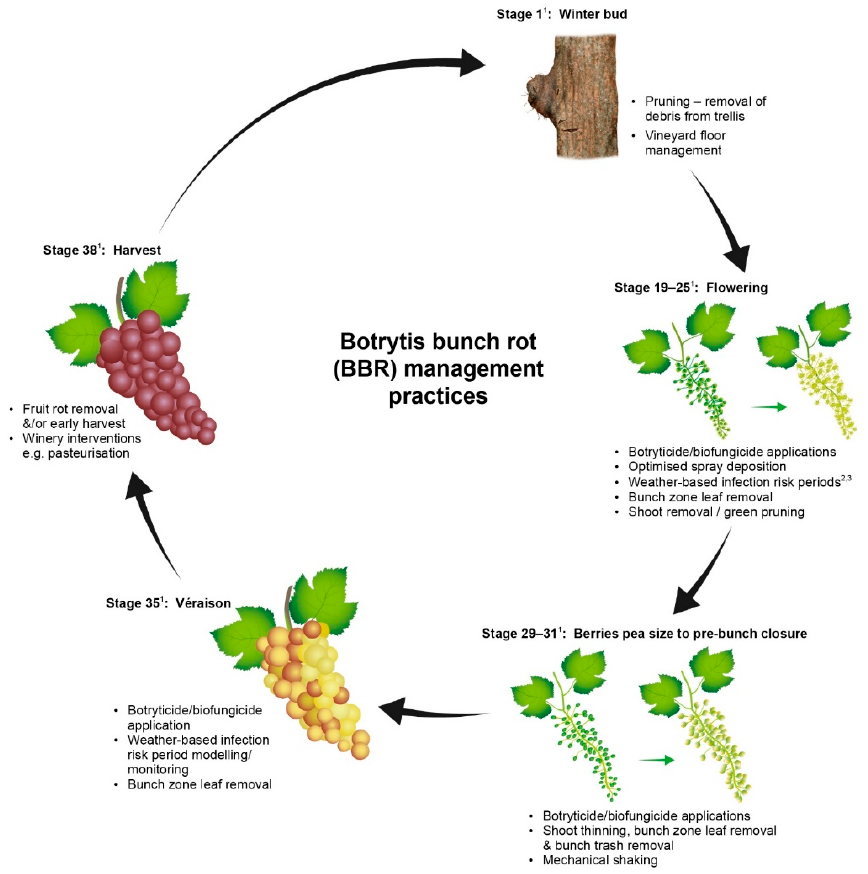
Figure 1. Phenological stage of the grapevine and botrytis bunch rot management options available to reduce risk of disease at harvest in New Zealand. (Superscript 1) This figure uses the modified Eichhorn-Lorenz phenological growth stages [38]. (Superscript 2,3) Examples of infection risk period modelling referred to in the figure are from Broome et al., 1995 [39] and Kim et al., 2007 [40].